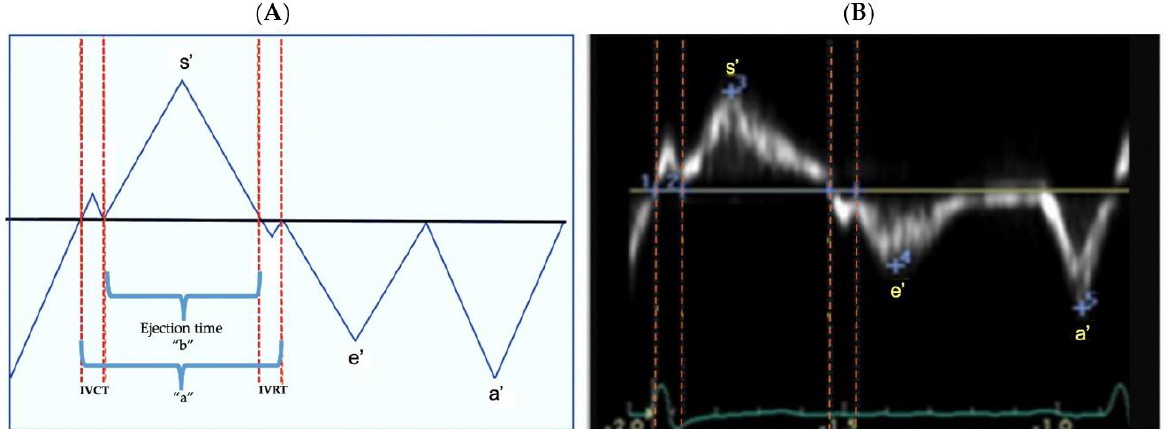
Figure 2. TDI derived myocardial velocities. Peak systolic velocity, s’, occurs during ejection time. The two diastolic velocities are e’ and a’ and correspond to myocardial movement during passive and active filling, respectively. Isovolumetric relaxation time (IVRT) is the time interval between the closure of the aortic valve and opening of the mitral valve occurring from the end of the s’ wave and the onset of the e’ wave. Isovolumetric contraction time (IVCT) is the time interval between the closure of the mitral valve and opening of the aortic valve occurring from the end of the a’ and onset of s’. Myocardial performance index is calculated from the formula (a – b/b). ( A ) Schematic representation. ( B ) TDI image.